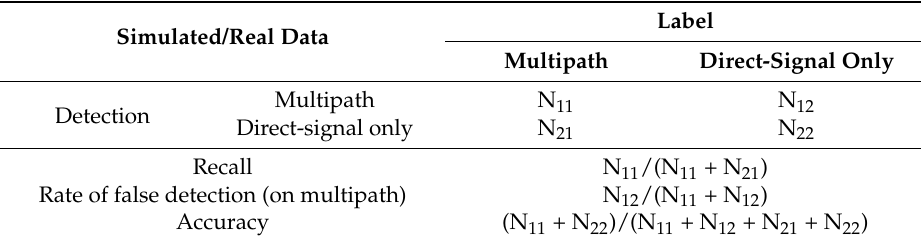
Table 2. Definition of recall, rate of false detection, and